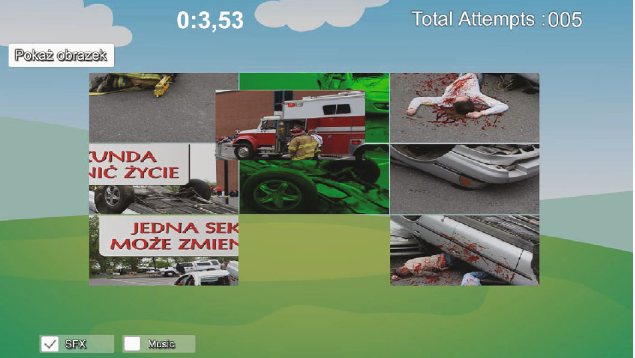
Figure 4: Screenshot showing a computer game of puzzling jigsaw